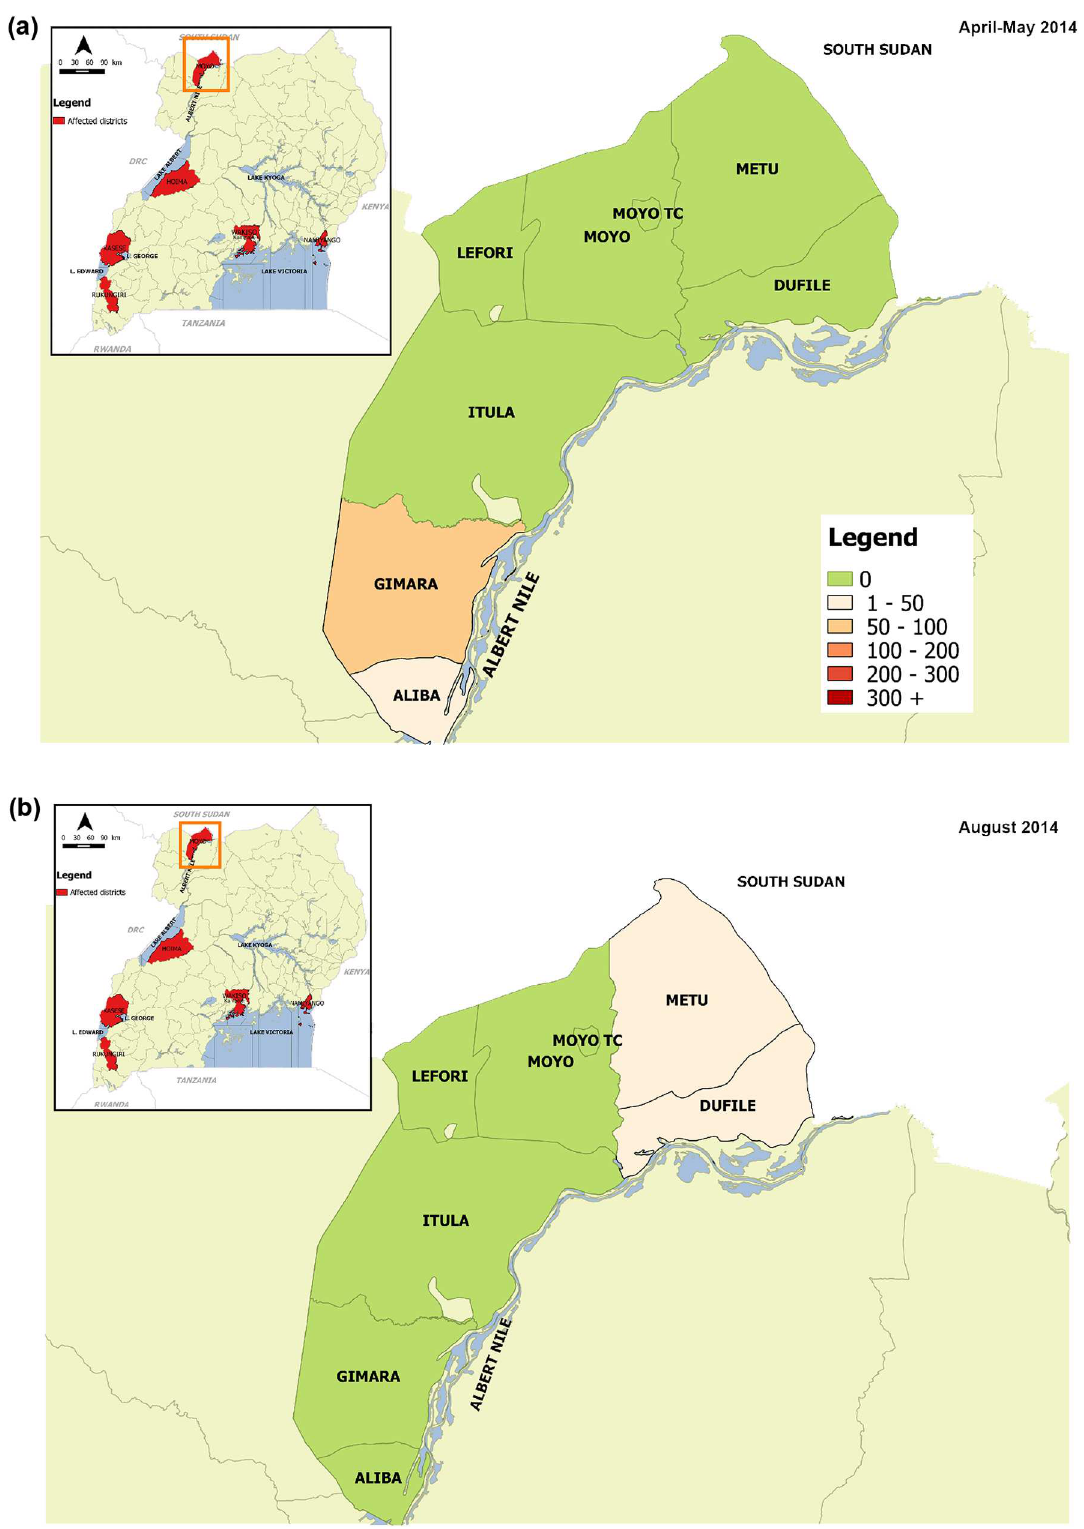
Fig 6. Cholera outbreaks that occurred in fishing villages along the Nile River. Fig 6a: Choleraoutbreak in Moyo district, April-May2014; Fig 6b: Choleraoutbreak in Moyo district, August 2014.